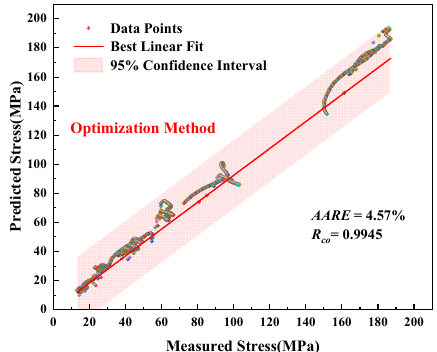
Figure 10. Correlation between measured and predicted stress of the modified JC model by optimi- zation method.